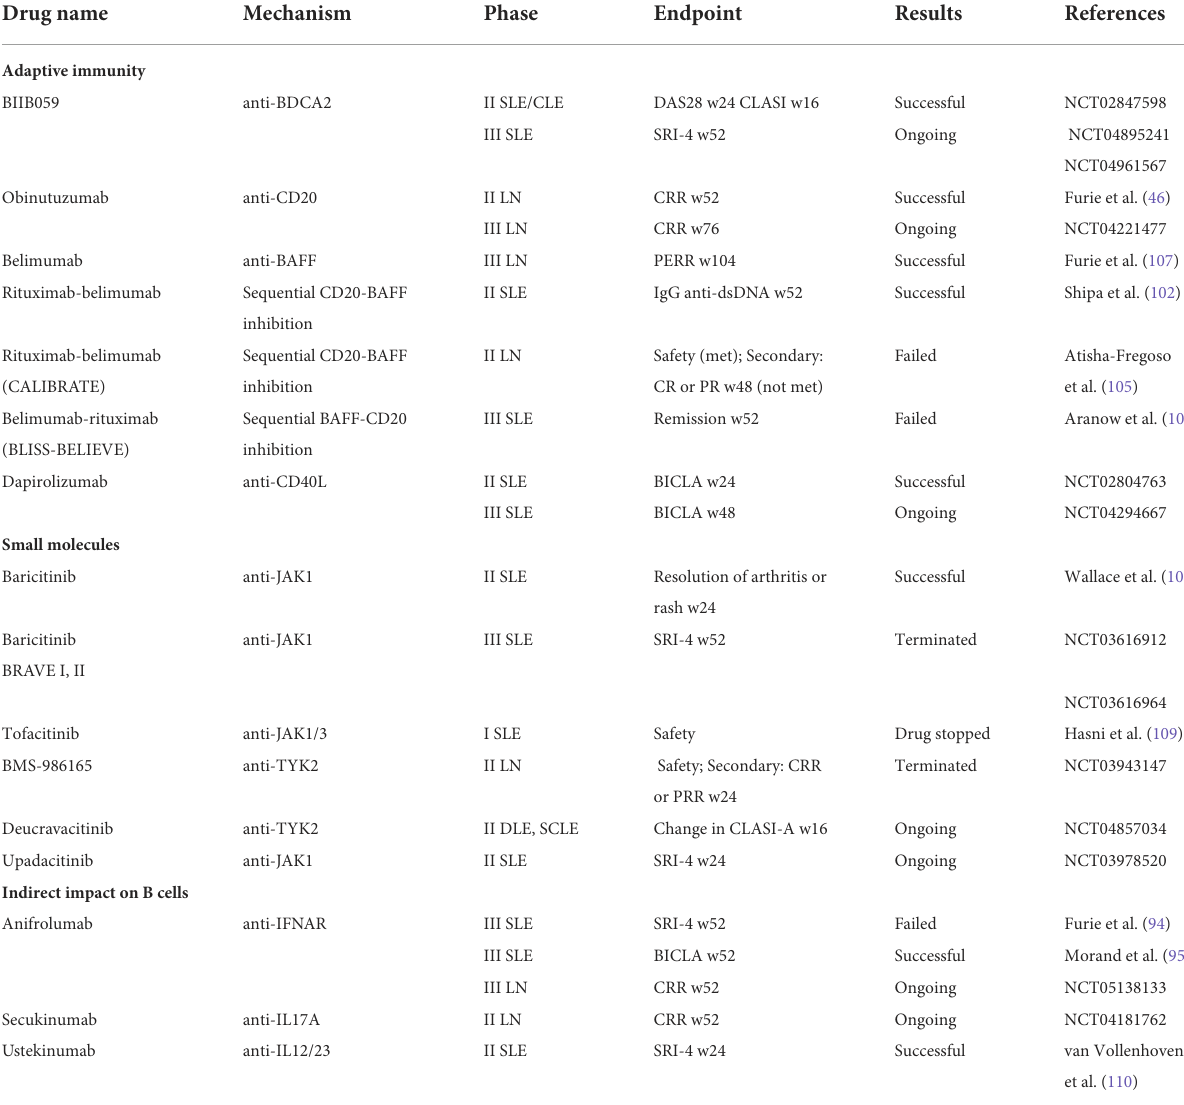
TABLE 1 Selected drugs studied for SLE and LN that exert direct or indirect effects on B